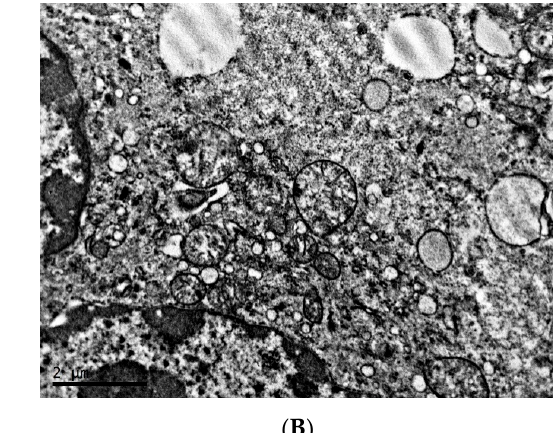
Figure 1. Morphological condition of tissue of transplantable malignant melanoma B16 under the influence of fixed light regime. TEM, ( A – D )—×6700.